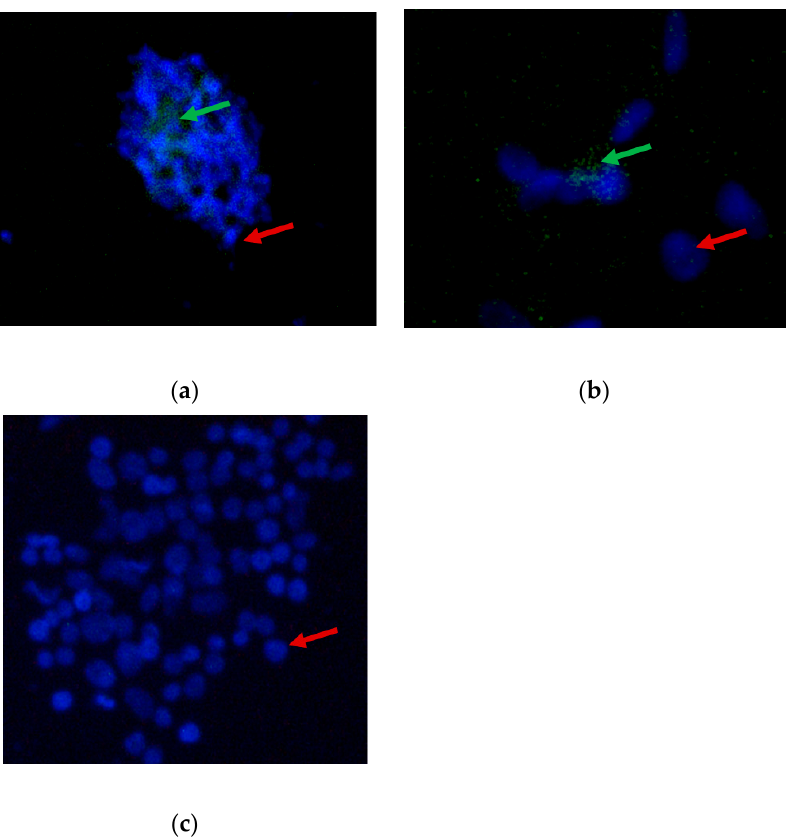
Figure 3. Indirect immunofluorescence images of CEL cells adapted Cytodex™ 1 microcarrier infected with FAdV isolates and propagated in a stirred tank bioreactor after 48 h incubation. ( a ) UPM08136CELP5B1 ×40; ( b ) UPM08136CELP20B1 ×40; ( c ) uninfected Control ×40. Red arrow indicates CEL cell nucleus; green arrow indicates FAdV in the cytoplasm of CEL cells.